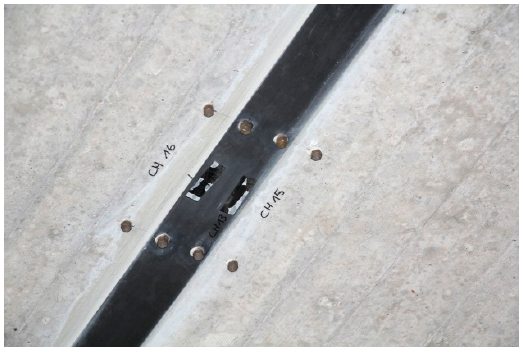
Figure 25. Measurement points at the mid-length of a CFRP strip.